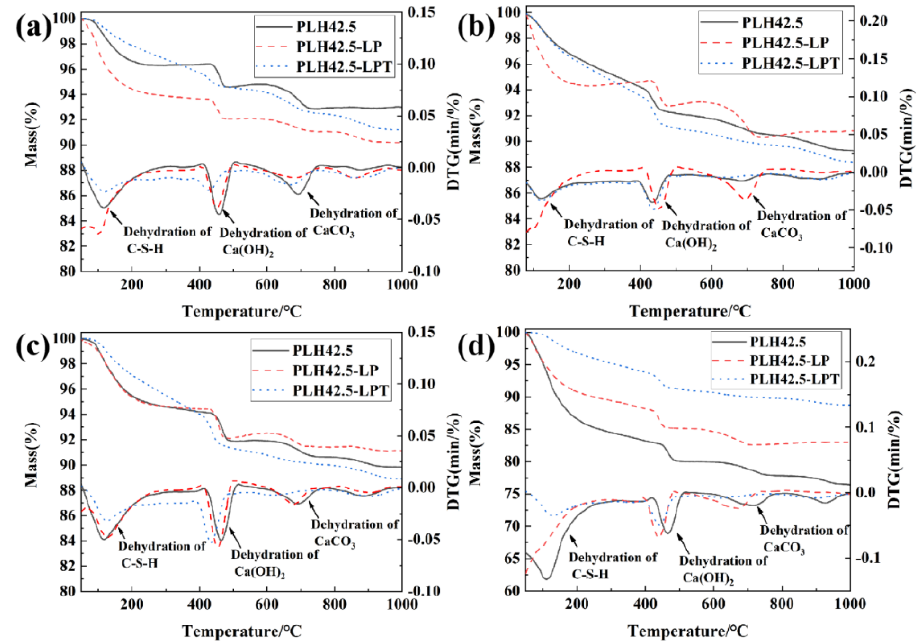
Figure 5. TG and DTG of the pastes cured for ( a ) 3, ( b ) 7, ( c ) 28, or ( d ) 90 d.